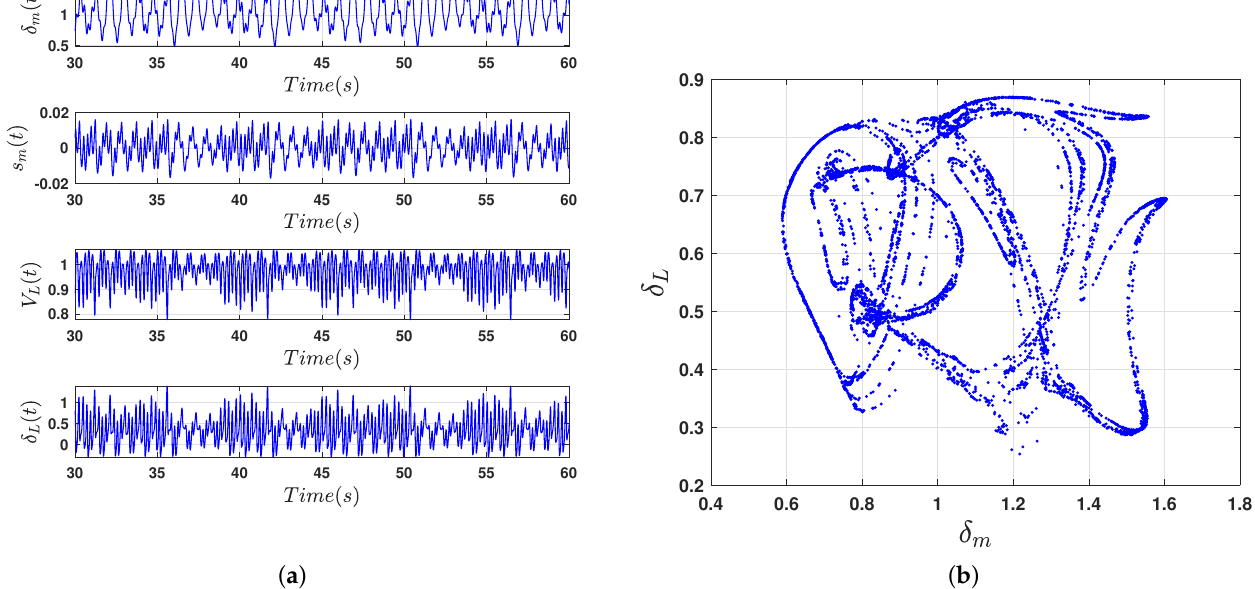
Figure 4. The chaotic power system (1) time series waveforms and its Poincaré map projection. ( a ) Time response of some state variables in the chaotic power system (1). ( b ) Poincaré map for the chaotic power system (1), projected in the δ m − δ L